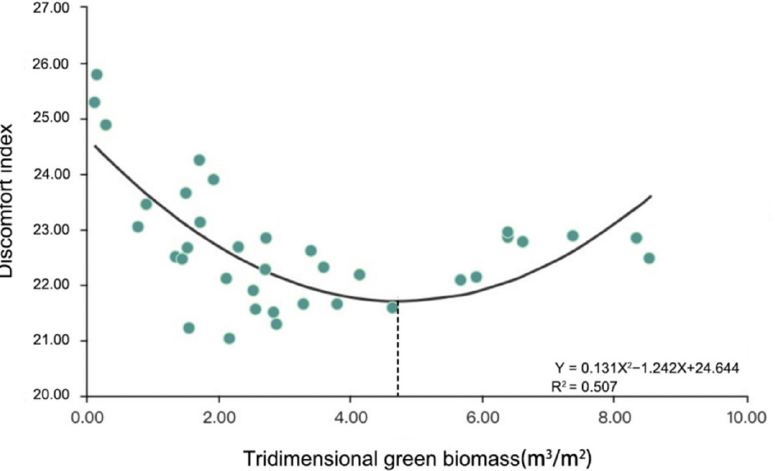
Figure 8. Relationship between discomfort index and tridimensional green biomass.